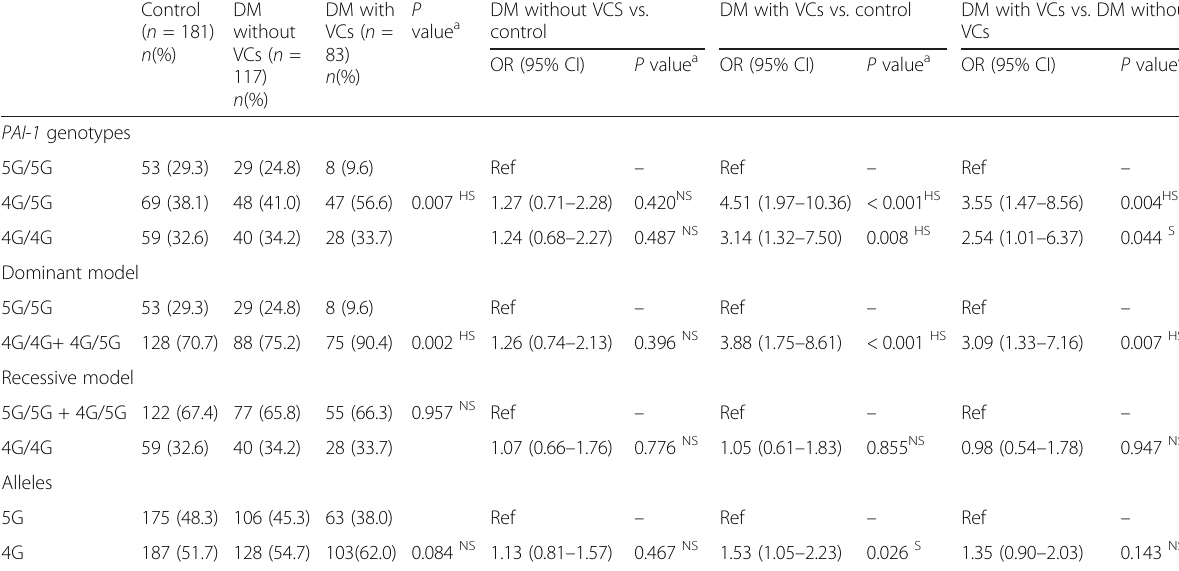
Table 2 Comparisons of genotype distribution and allele frequencies of PAI - 1 gene polymorphism between healthy control, DM without vascular complications, and DM with vascular complications